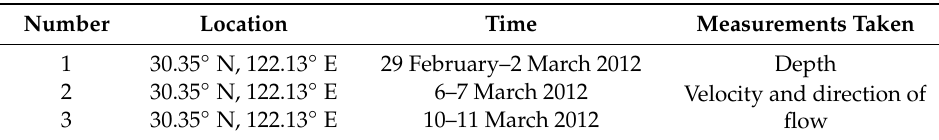
Figure 2. Tidal levels for 29 February–2 March 2012 ( a ), 6–7 March 2012 ( b ) and 10–11 March 2012 ( c ). Table 4. In situ